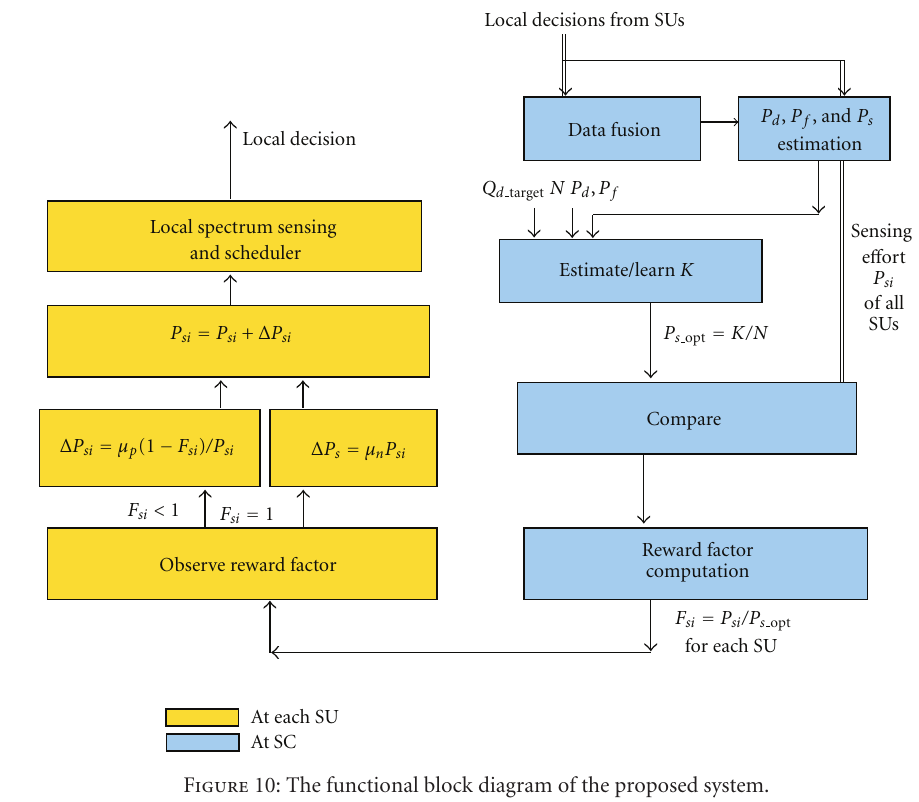
Figure 10: The functional block diagram of the proposed system.